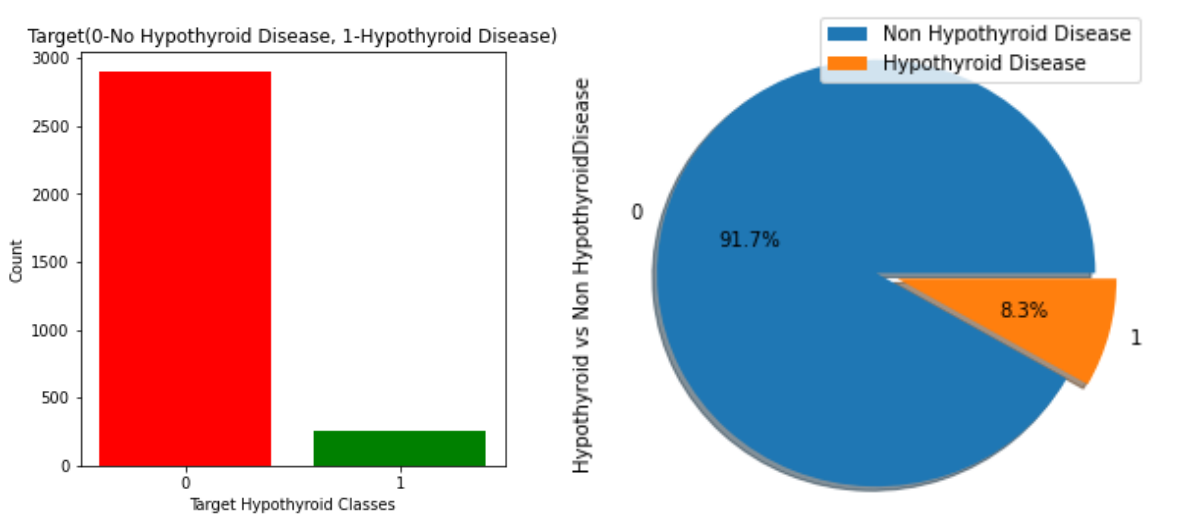
Figure 6. Density plot and target distribution of the hypothyroidism dataset.